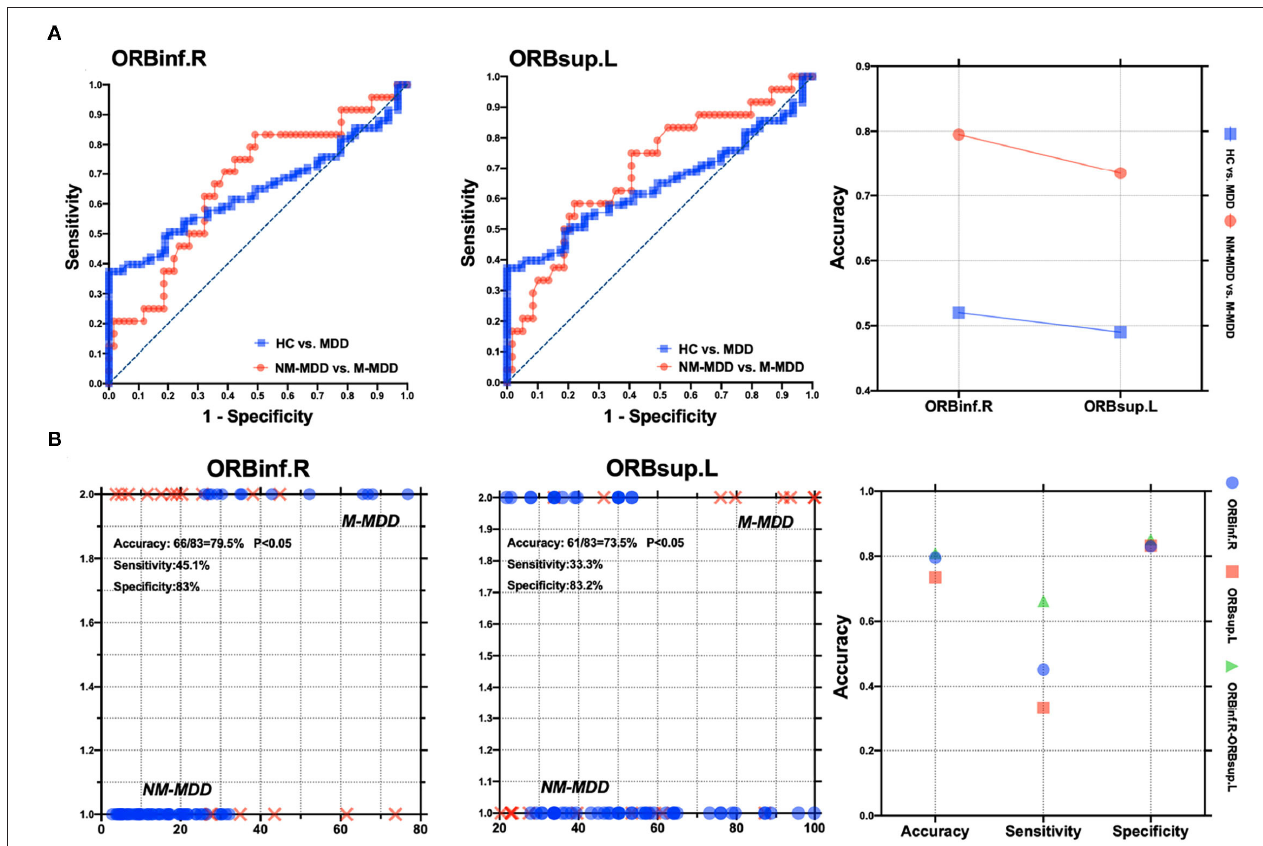
FIGURE 4 | Visualization of classification by using support vector machine (SVM) using the aBC values of ORBinf.R and ORBsup.L. (A) Visualization of parameters from healthy controls vs. MDD patients and NM-MDD vs. M-MDD. (B) Classification map of aBC values in ORBinf.R and ORBsup.L and SVM parameters as two features. L, Left hemisphere; R, Right hemisphere; ORBinf, Orbital inferior frontal gyrus; ORBsup, Orbital superior frontal